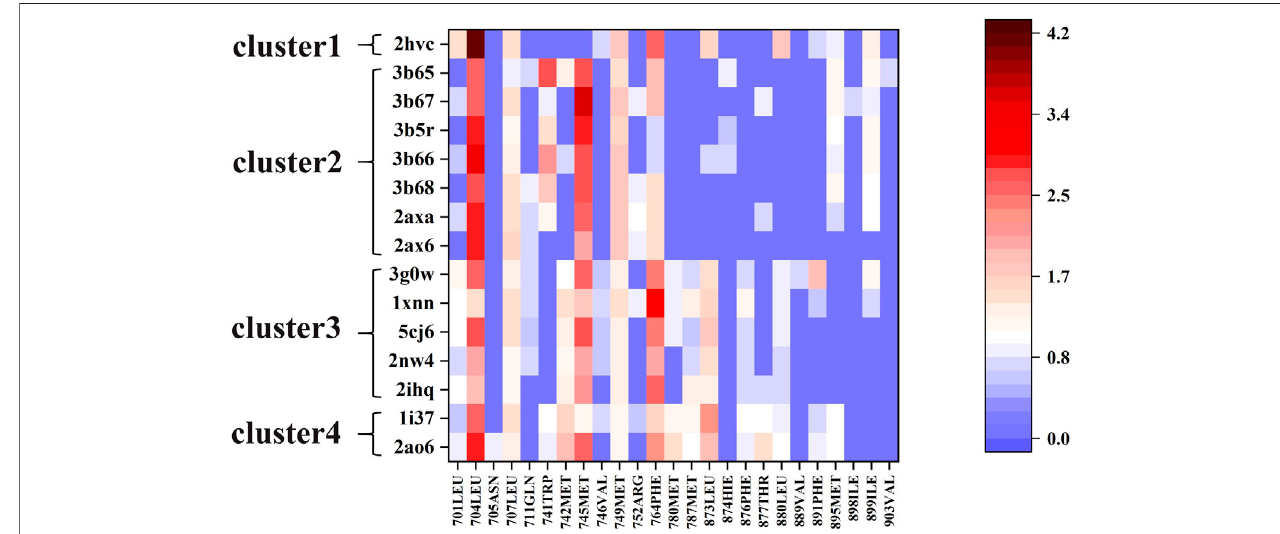
FIGURE 2 | The free energy contributions of each pocket residue in the 15 systems.